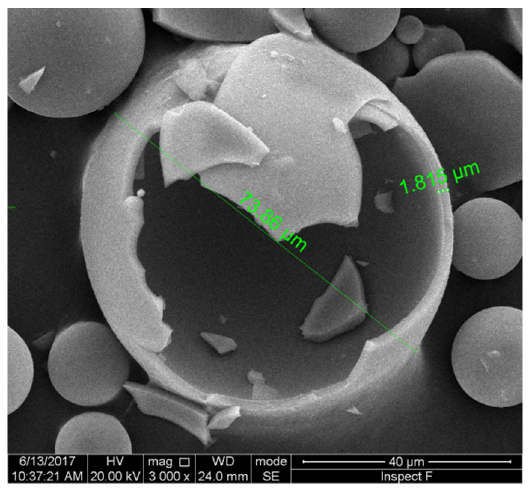
Figure 3. SEM image of cracked hollow glass microspheres.